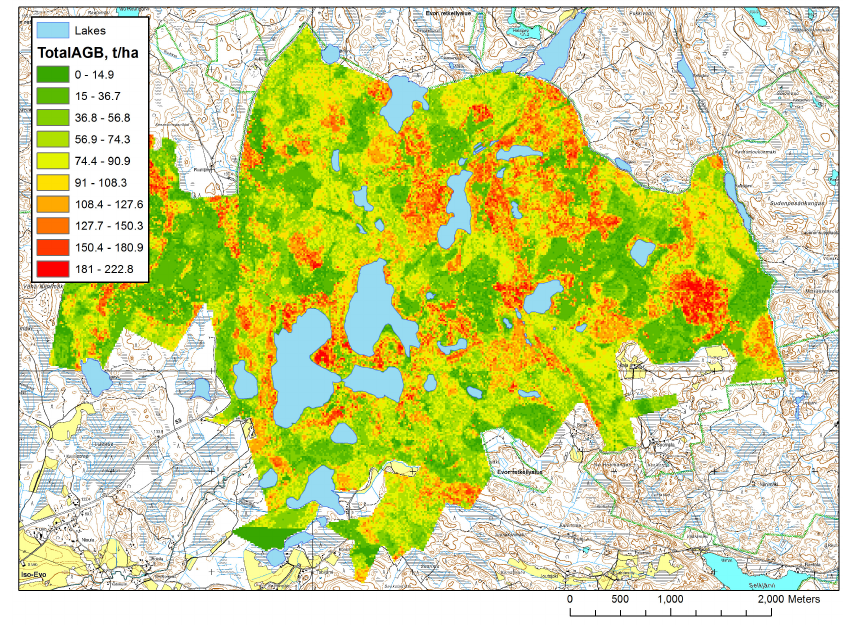
Figure 1. Aboveground biomass (AGB) estimation with lidar using area based approach in Evo, southern Finland.